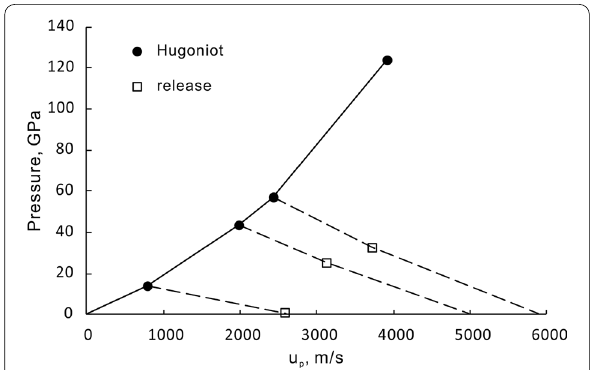
Fig. 4 Measured Hugoniot and release state of the Bruderheim L6 chondrite in particle velocity–pressure space, after Anderson and Ahrens